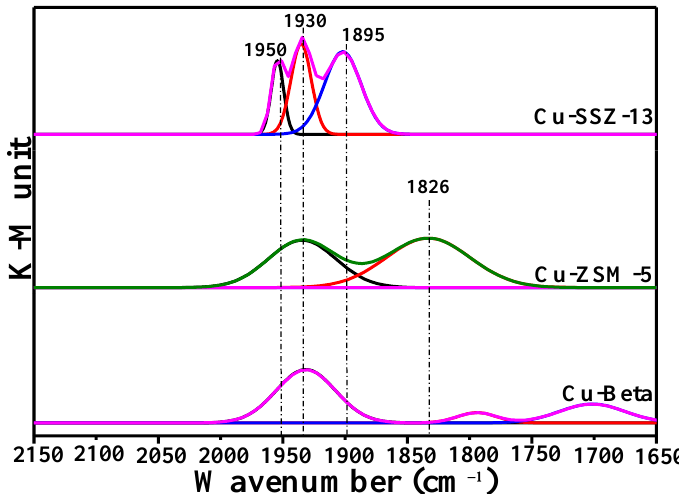
Figure 8. DRIFT Spectra of NO adsorption on the copper-based zeolites (Prior to NO adsorption, each catalyst was oxidized at 500 °C for 60 min).